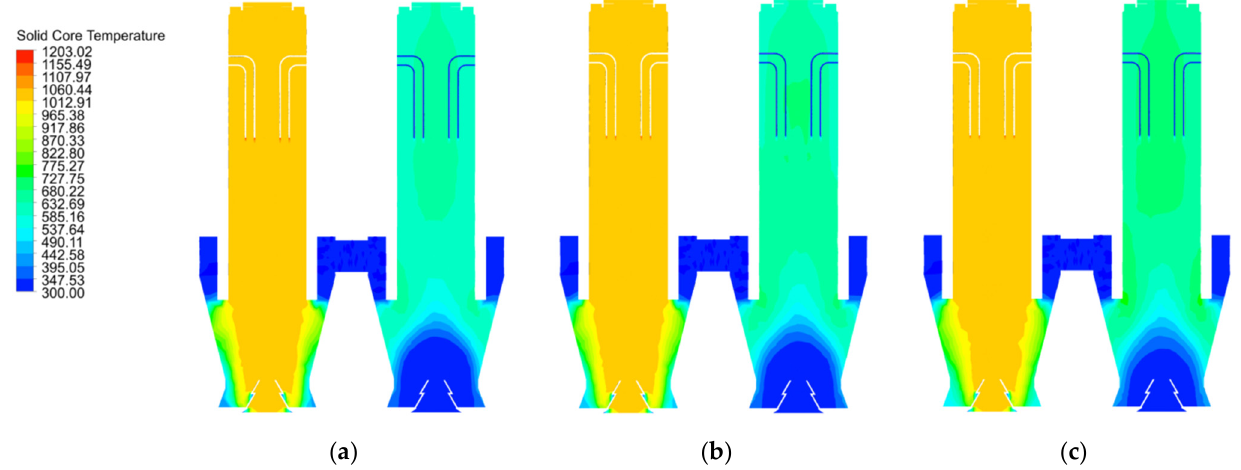
Figure 15. Solid surface temperature distribution at 40 mm, 80 mm and 120 mm particle sizes. ( a ) 40 mm solid core temperature distribution ( b ) 80 mm solid core temperature distribution ( c ) 120 mm solid core temperature distribution.